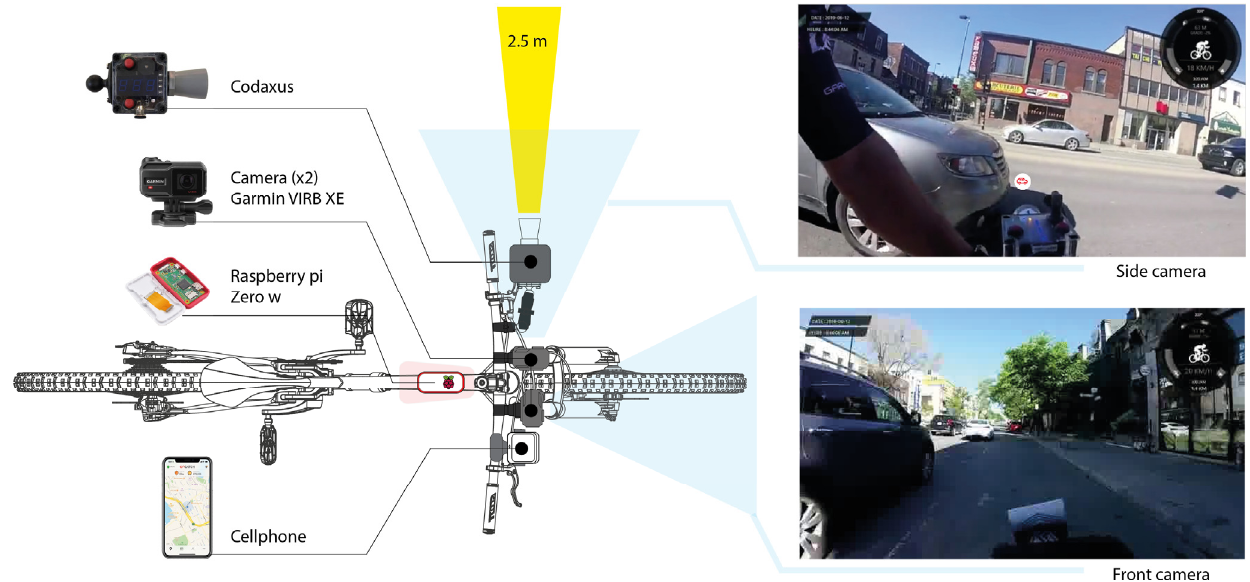
Figure 2. The devices used for collection, attached to the bicycle.